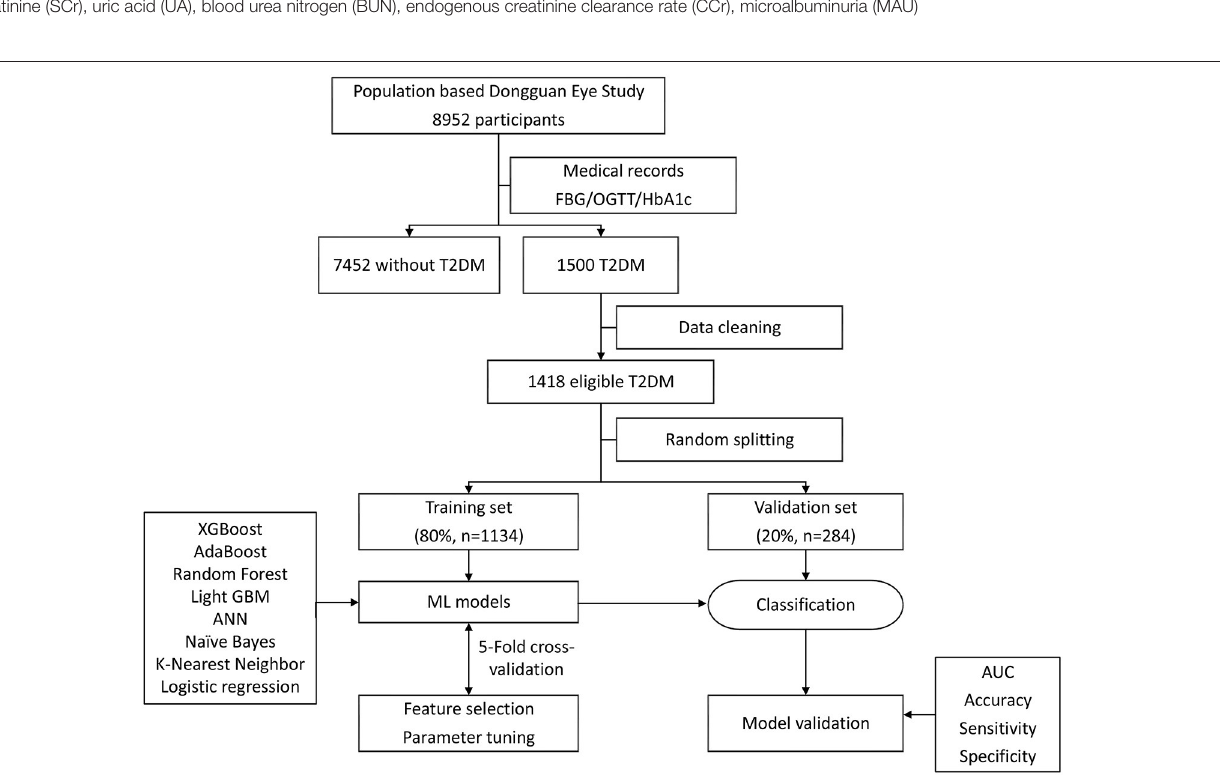
FIGURE 1 | Machine learning flowchart of this study. ML, machine learning; XGBoost, extreme gradient boosting; ANN, artificial neural network; AdaBoost, adaptive boosting; GBM, gradient boosting